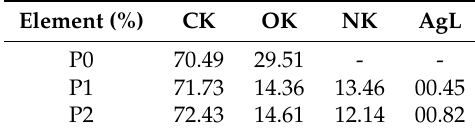
Table 2. EDAX results of PLLA studied